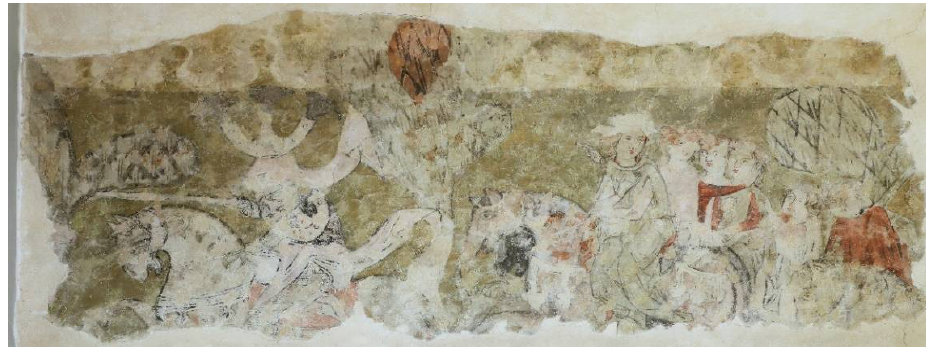
Figure 26. Prague, House No. 144/I on Malé náměstí. Knightly scenes. End of the 1st half of the 14th century. Photo by František Záruba, the author’s own work.